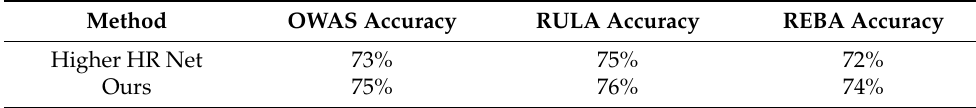
Table 8. Evaluation and comparison of higher HR Net feature extracted